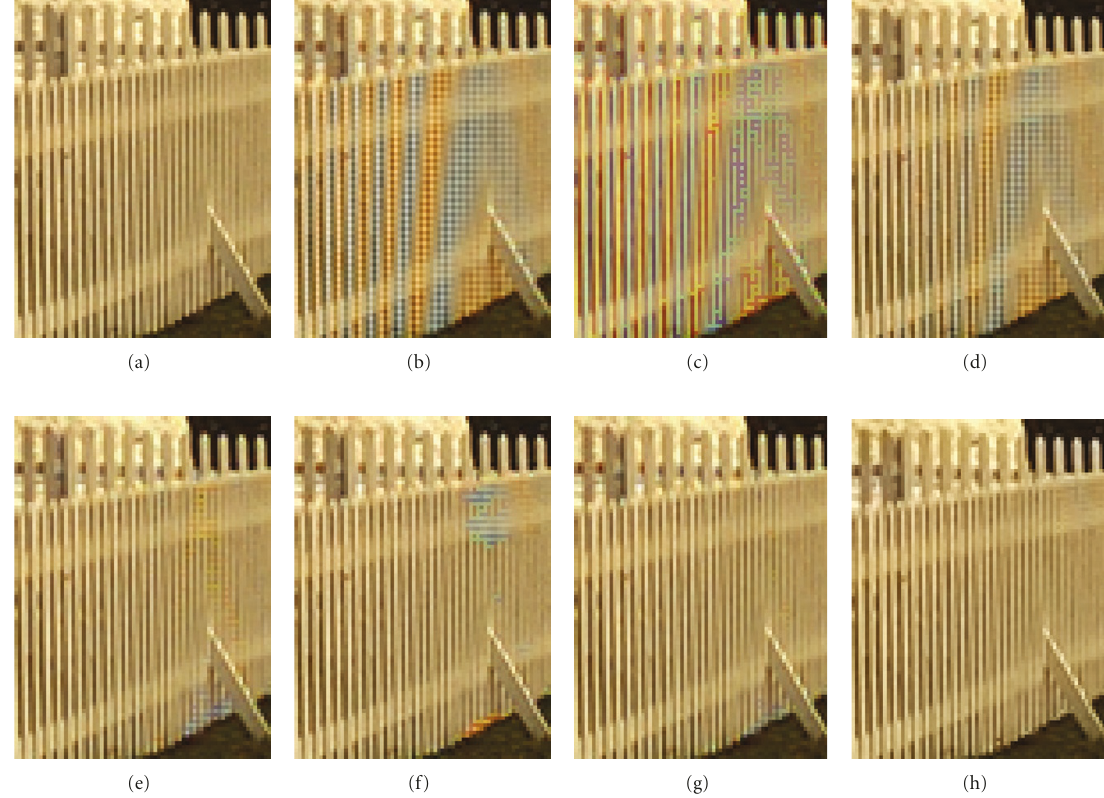
Figure 13: Partially magnified Kodak 19 image: (a) original image, (b) method discussed in [7], (c) method discussed in [10], (d) method discussed in [15], (e) method discussed in [22], (f) method discussed in [24], (g) method discussed in [27], and (h) Proposed